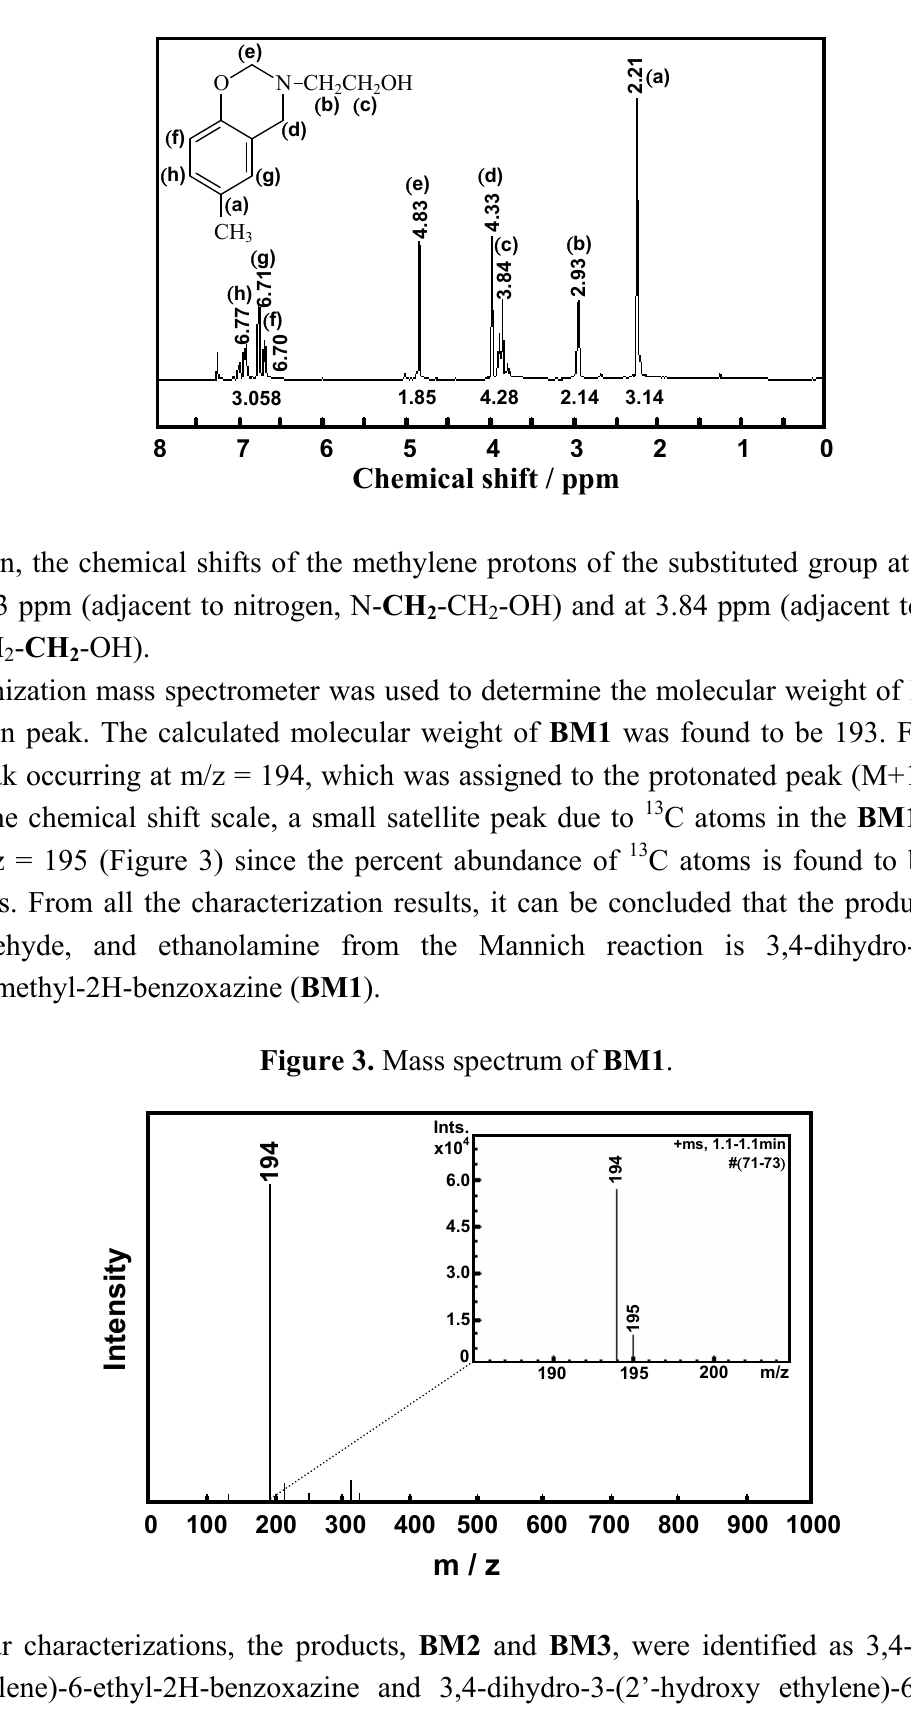
Figure 2. 1 H-NMR spectrum of BM1 .